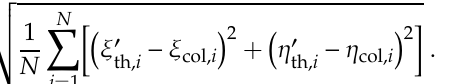
Figure 7. Example of a pair of captured images of a light source. ( a ) Thermal image and ( b ) color image (image pair No. 7 in Figure A1). The red and blue frames are identical to those shown in Figure 2.